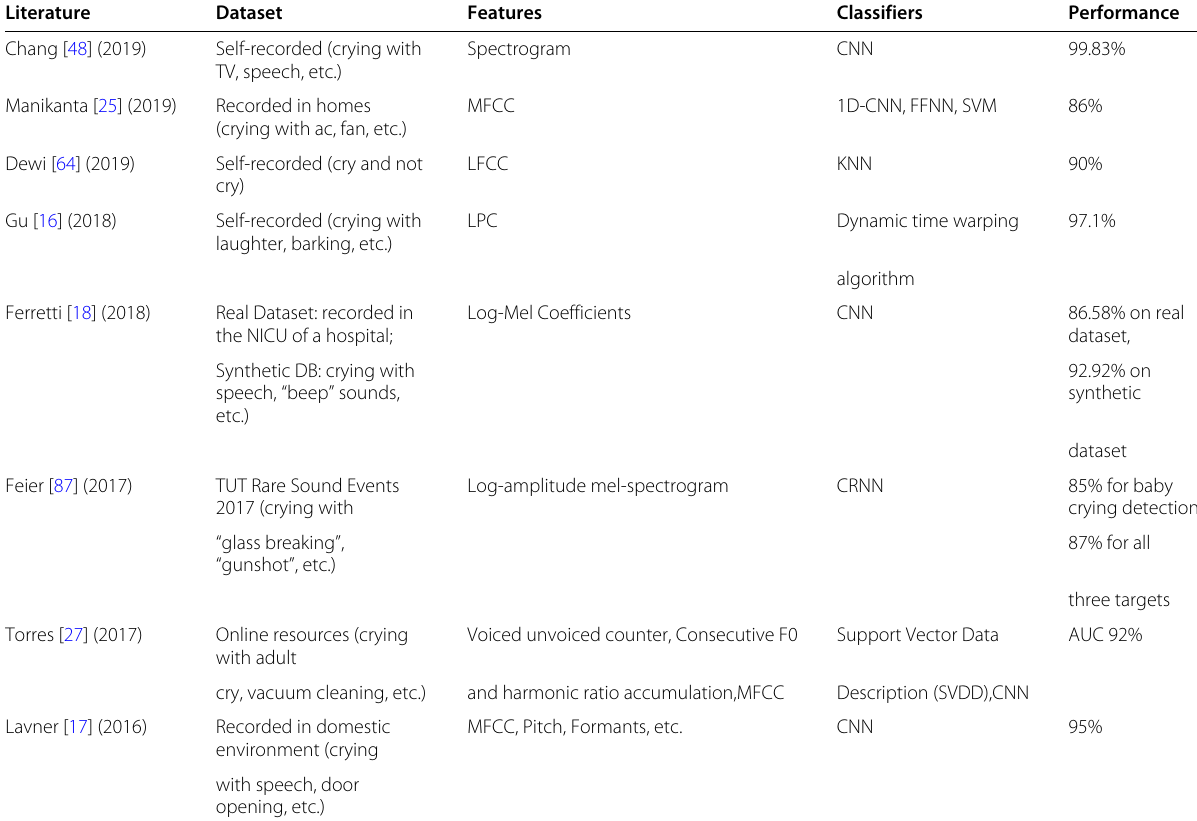
Table 4 Significant works on infant cry detection Literature